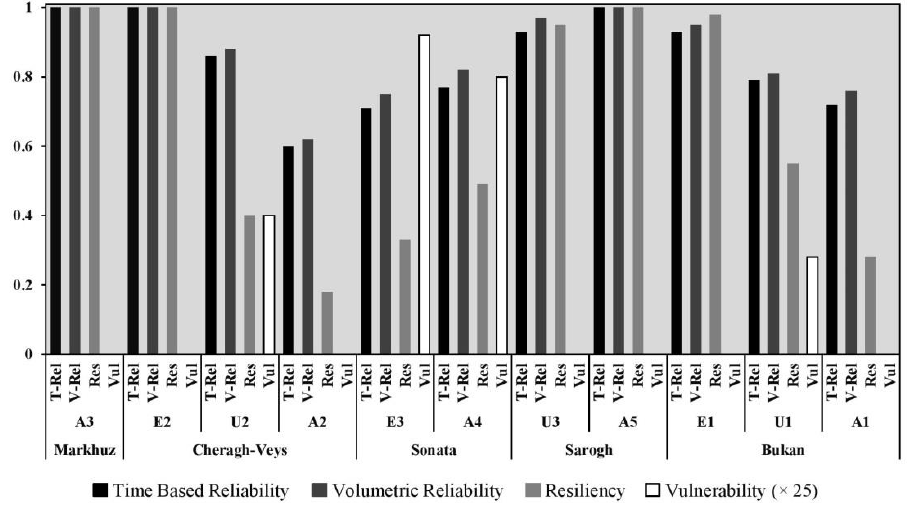
Figure 8. Risk-based performance criteria computed for Zerrine-rud demand sites.